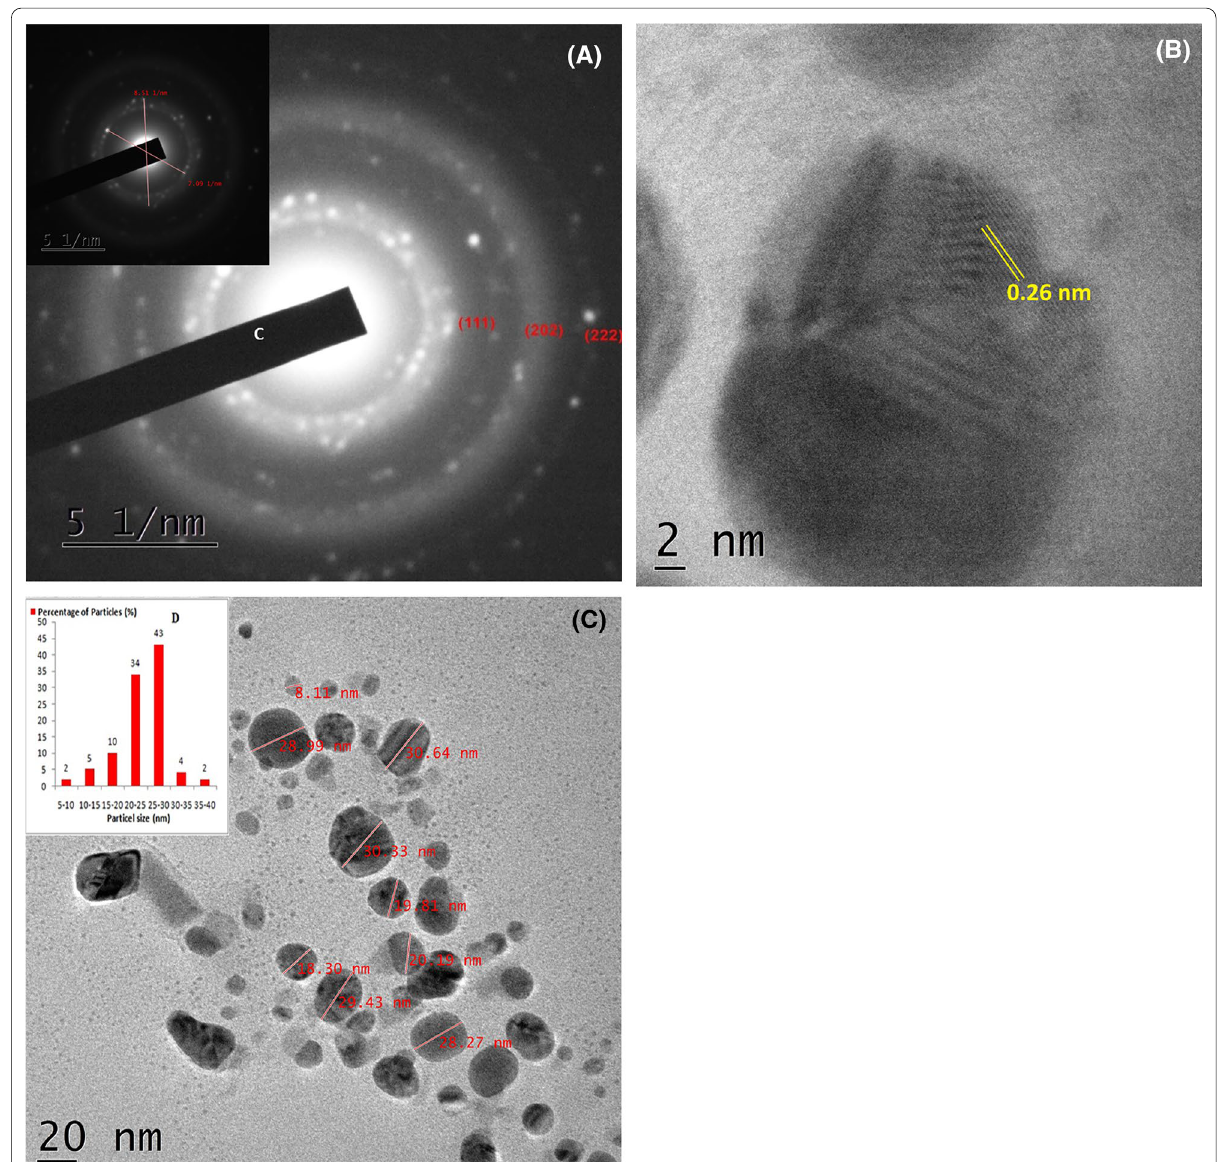
Fig. 2 a The SEAD pattern for sample 1S5: shows diffuse rings overlaid with distinct spots indicating the presence of crystalline component to an otherwise amorphous material. Inset in figure show the orthogonal lattice spacing. b TEM image for sample 1S5 showing a single grain with the d-spacing of 0.26 nm. c TEM image for sample 1S5 showing the distribution in size of the formed Ag-NPs and inset is the histogram representing average particle size distribution in the aqueous